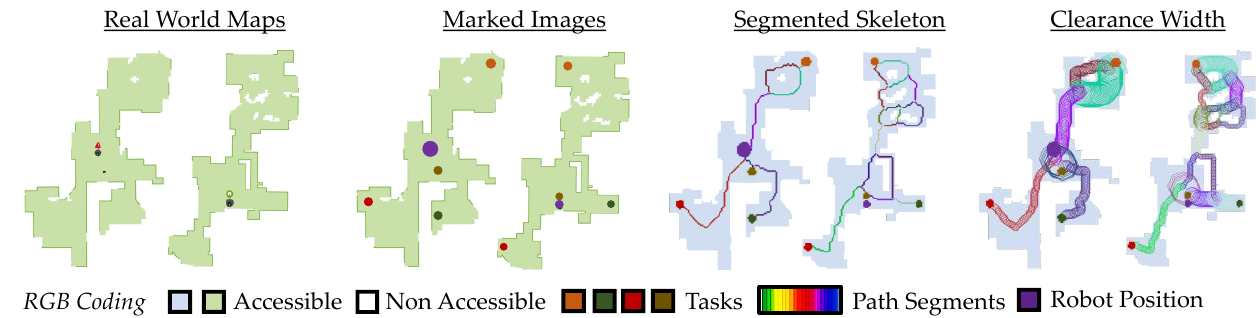
Figure 26. Generation of graphs in a real world use case: two maps, two marked images, two segmented skeletons and two path suggestions including clearance width.